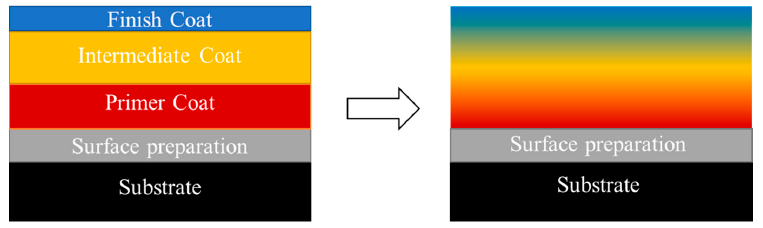
Figure 1. Self-layering concept.